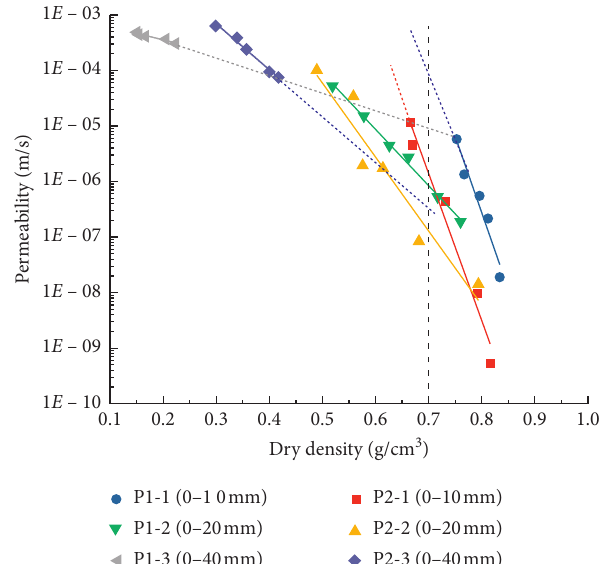
Figure 7: Relationship between the permeability and the dry density of samples with different particle sizes.